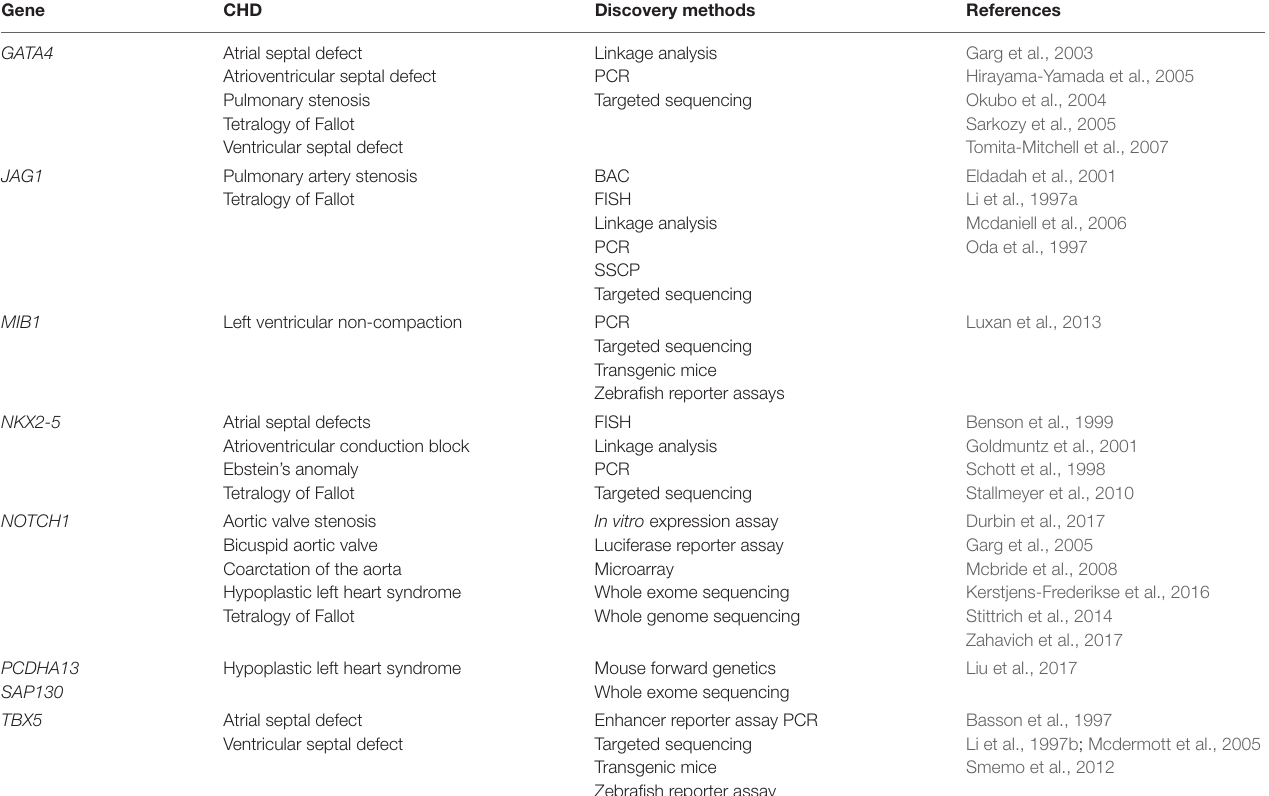
TABLE 1 | A summary of single-gene variants underlying